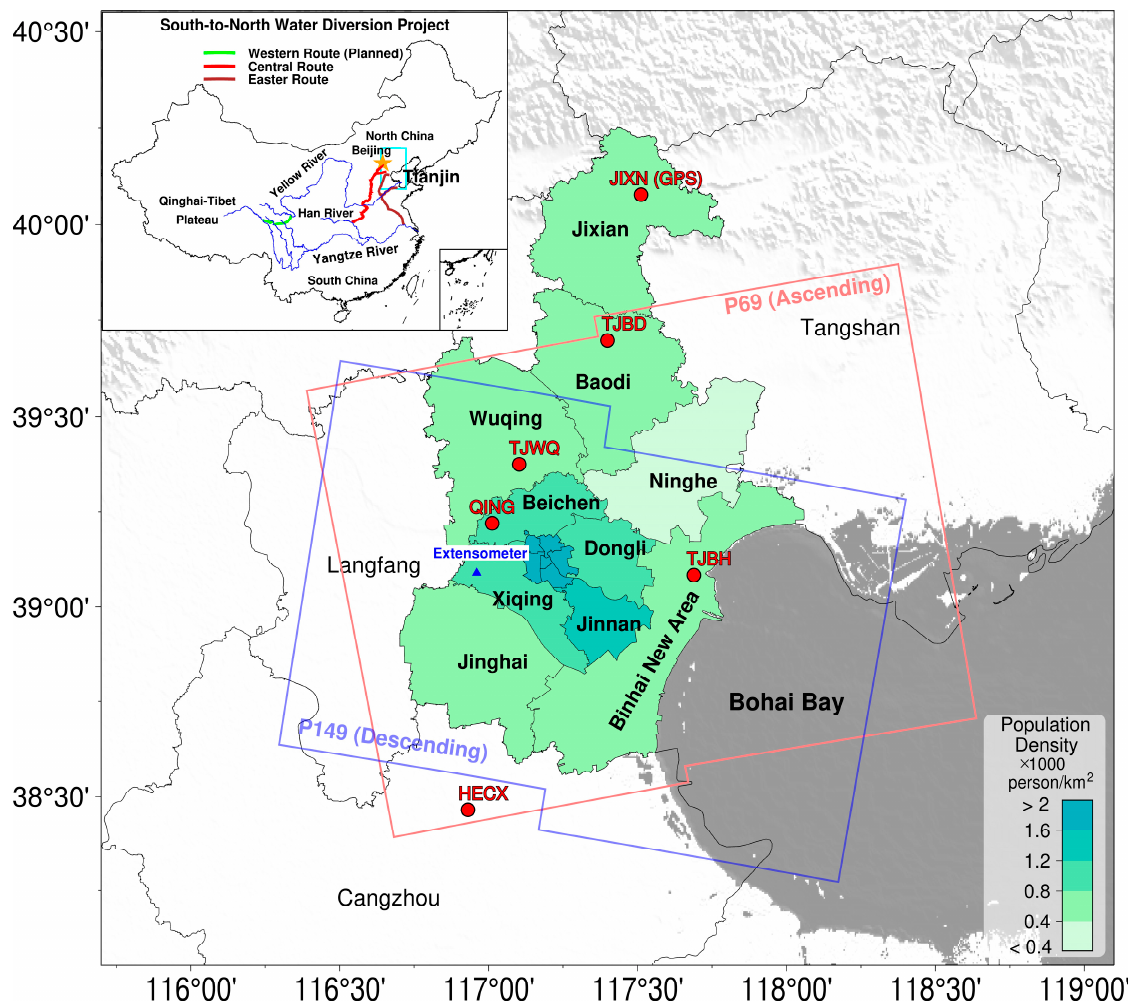
Figure 1. The locations of three routes of the South-to-North Water Diversion (SNWD) project, the extensometer-piezometer station in Xinkou town, Xiqing District, and continuous GPS stations used in this study (JIXN, TJBD, TJWQ, QING, TJBH, and HECX). P69 and P149 indicate the areas covered by Sentinel-1 Path 69 and Path 149, respectively. The background color indicates the population density (person/km 2 ) of Tianjin in 2021 [1].